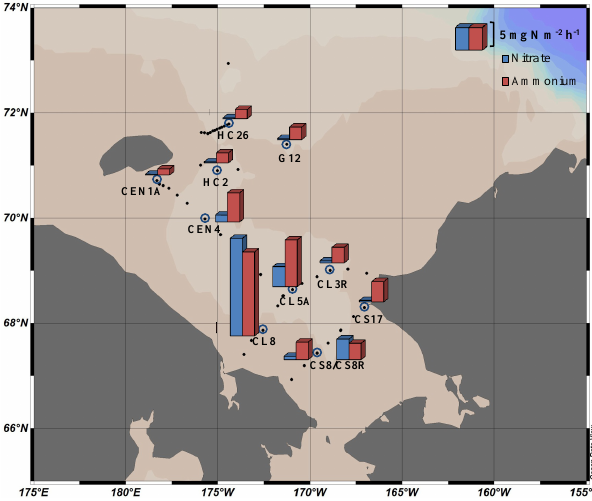
Figure 4. The chlorophyll a content in the upper 30m (mgm − 2 ) during the 2012 RUSALCA expedition.